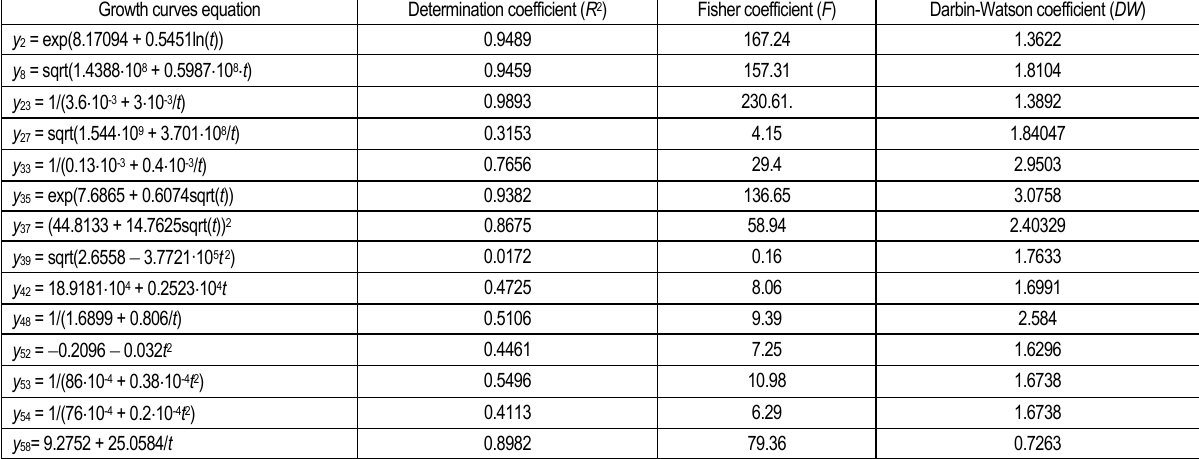
Table 3. Growth curve equation of socioeconomic development indexes of Brazil Growth curves equation